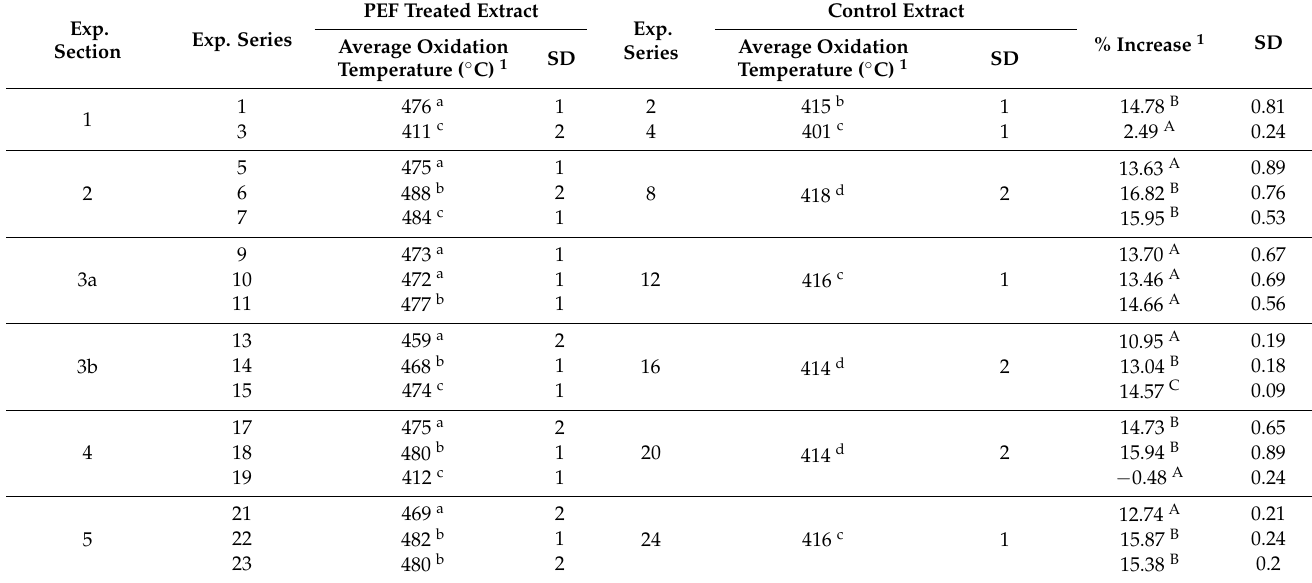
Table 4. DSC results on the oxidation temperature ( T max ) of the various